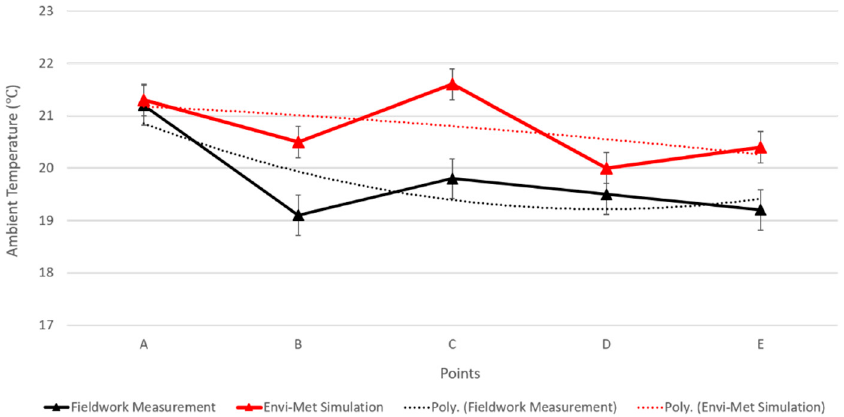
Figure 4. Comparison of ambient temperature recorded at field measurement with simulations in track 2.